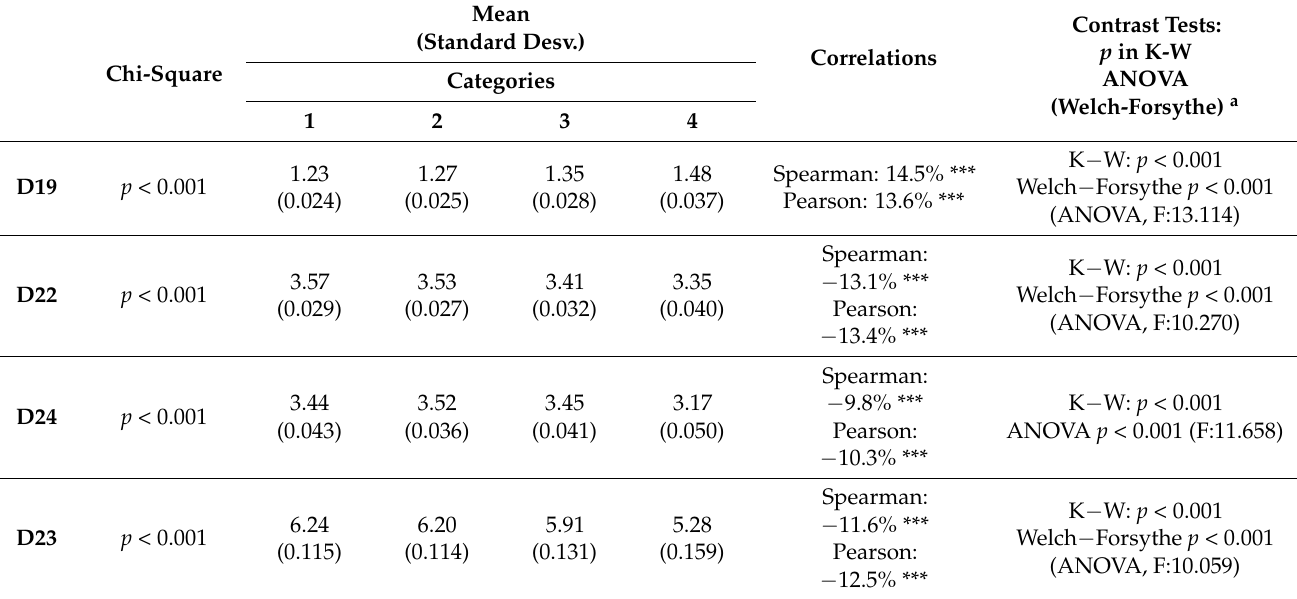
Table 2. Measures for variables used in the